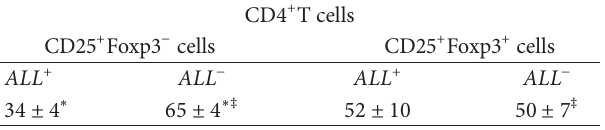
Table 1: Recognition of CD25 + Foxp3 + CD4 + T-cell subsets by Amaranthus leucocarpus lectin ( ALL